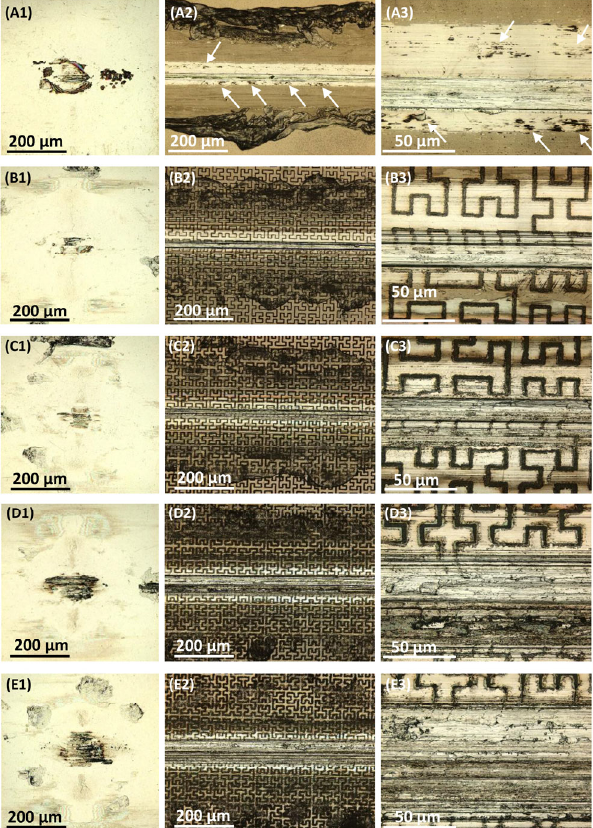
Fig. 11 Optical images of the counterface balls and wear tracks: (A1)–(E1) counterface balls and (A2)–(E2) wear tracks after the durability test on PDA/PTFE coatings on smooth and laser textured stainless steel with the texture path segment length of 12 μ m and LP of (A) 0, (B) 5%, (C) 10%, (D) 15%, and (E) 20%. (A3)–(E3) are zoom-in images of (A2)–(E2). The arrows in (A2) and (A3) point to small amounts of PTFE residue inside the wear track.